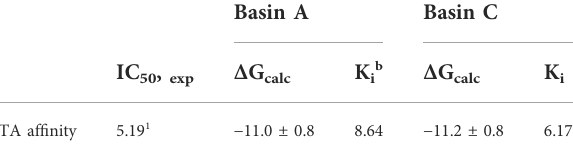
Experimental af fi nity data for Bombyx mori was obtained from Ohta et al. (2004) and was converted with the relation Δ G = − RT ln ( K i ). b The IC 50 , K i , and Δ G units are in nM, nM, and kcal.mol − 1 ,